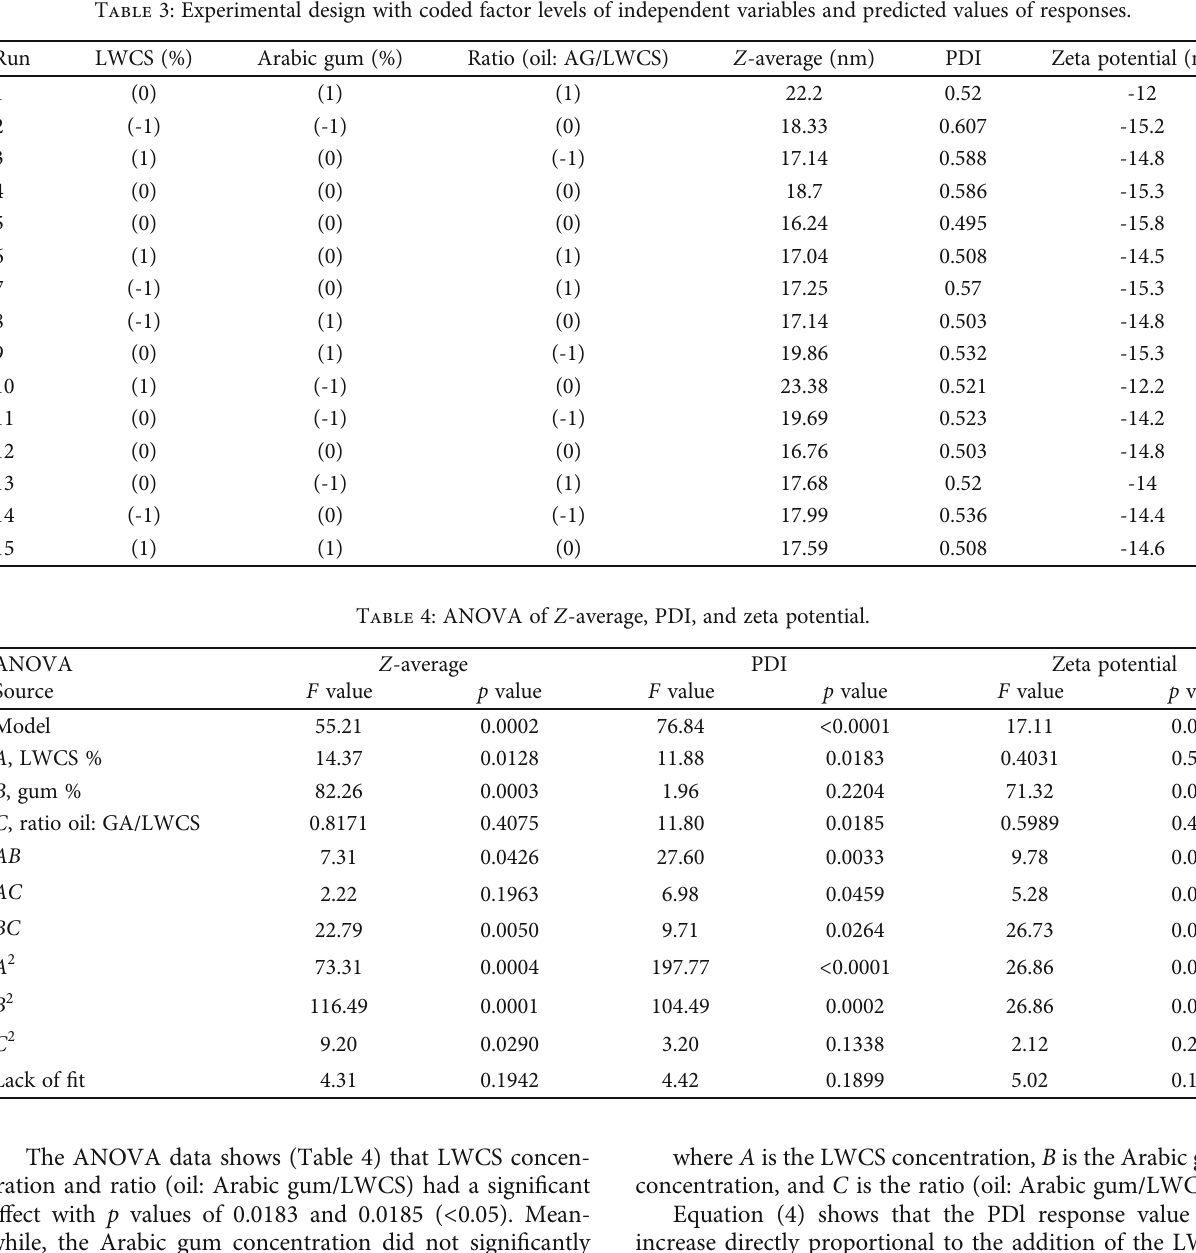
Table 3: Experimental design with coded factor levels of independent variables and predicted values of responses.